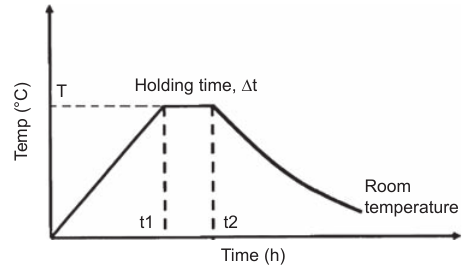
Figure 1 Schematic set-up for upward and downward infi ltration of liquid Mg alloys into AlN preform inside the BN crucible.